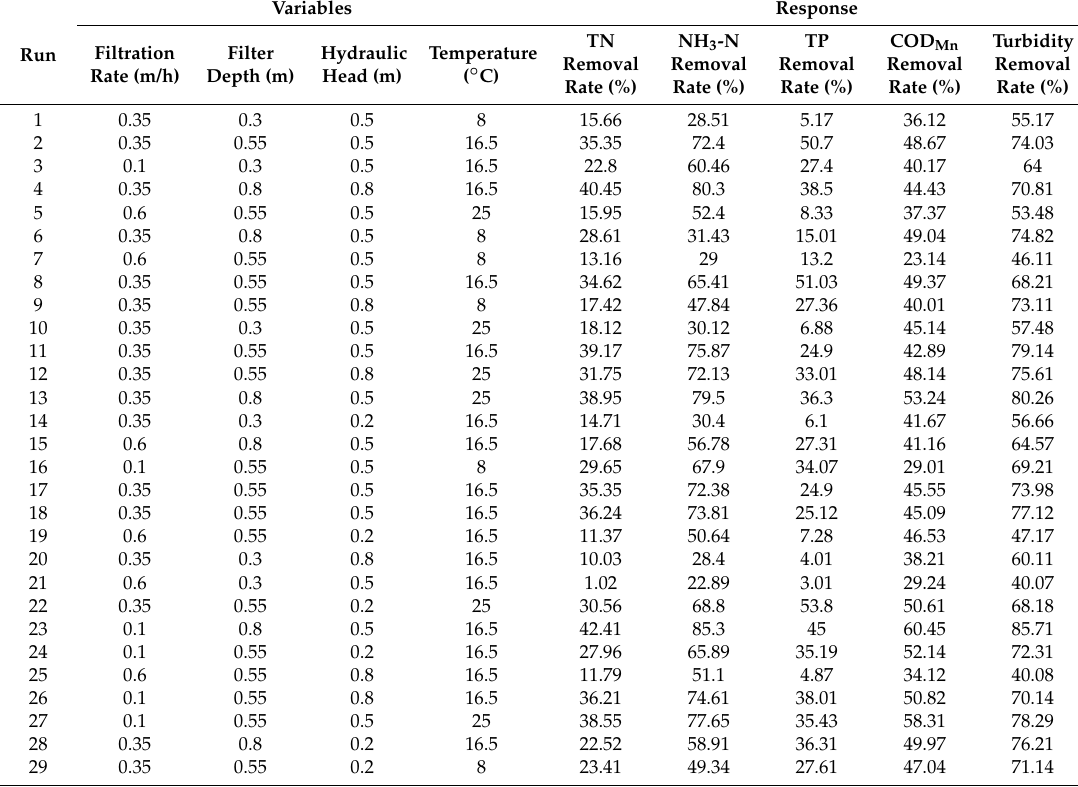
Table 4. A Box-Behnken experiment design (BBD) with Response surface